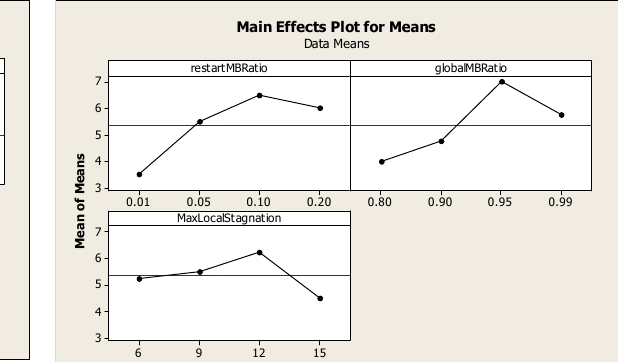
Fig. 17. The output of MINITAB for the successful hits of the DMSA